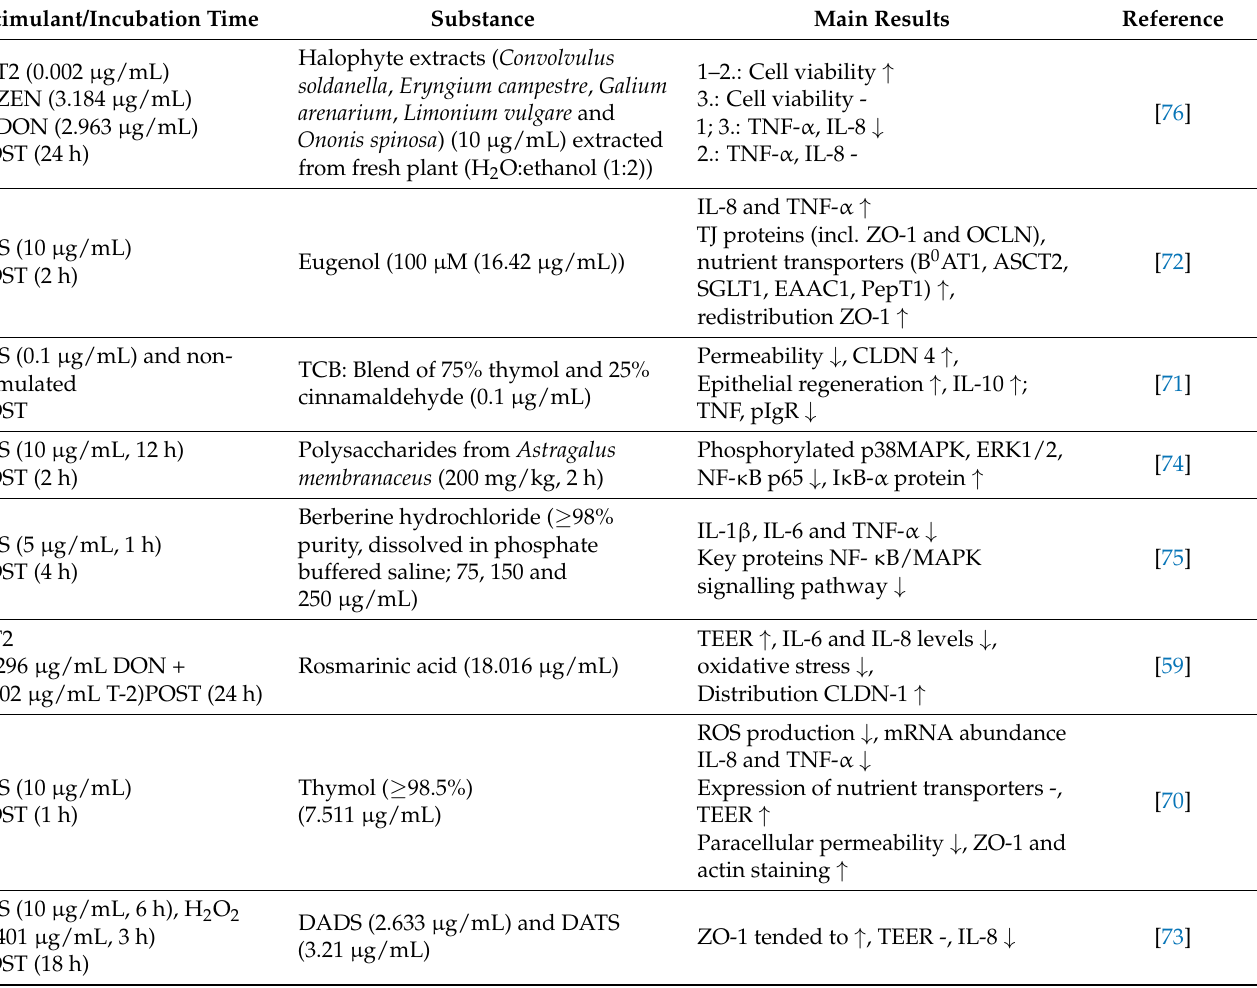
Table 3. Anti-inflammatory effects of PFA on IPEC-J2